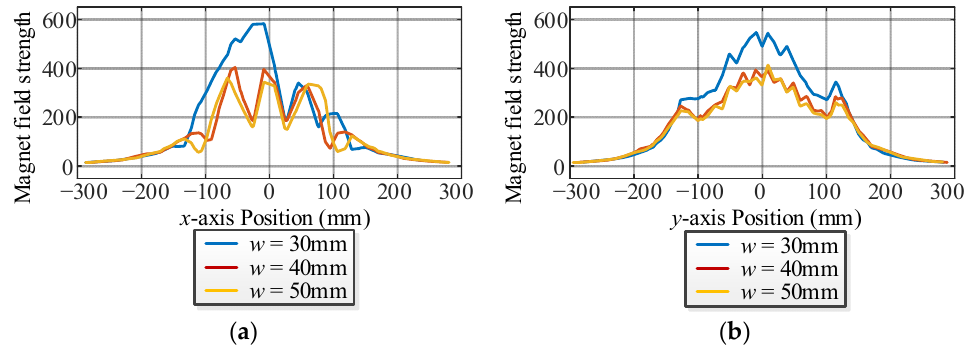
Figure 11. Magnet field strength waveforms with different widths. ( a ) x ‐ axis. ( b ) y ‐ axis.